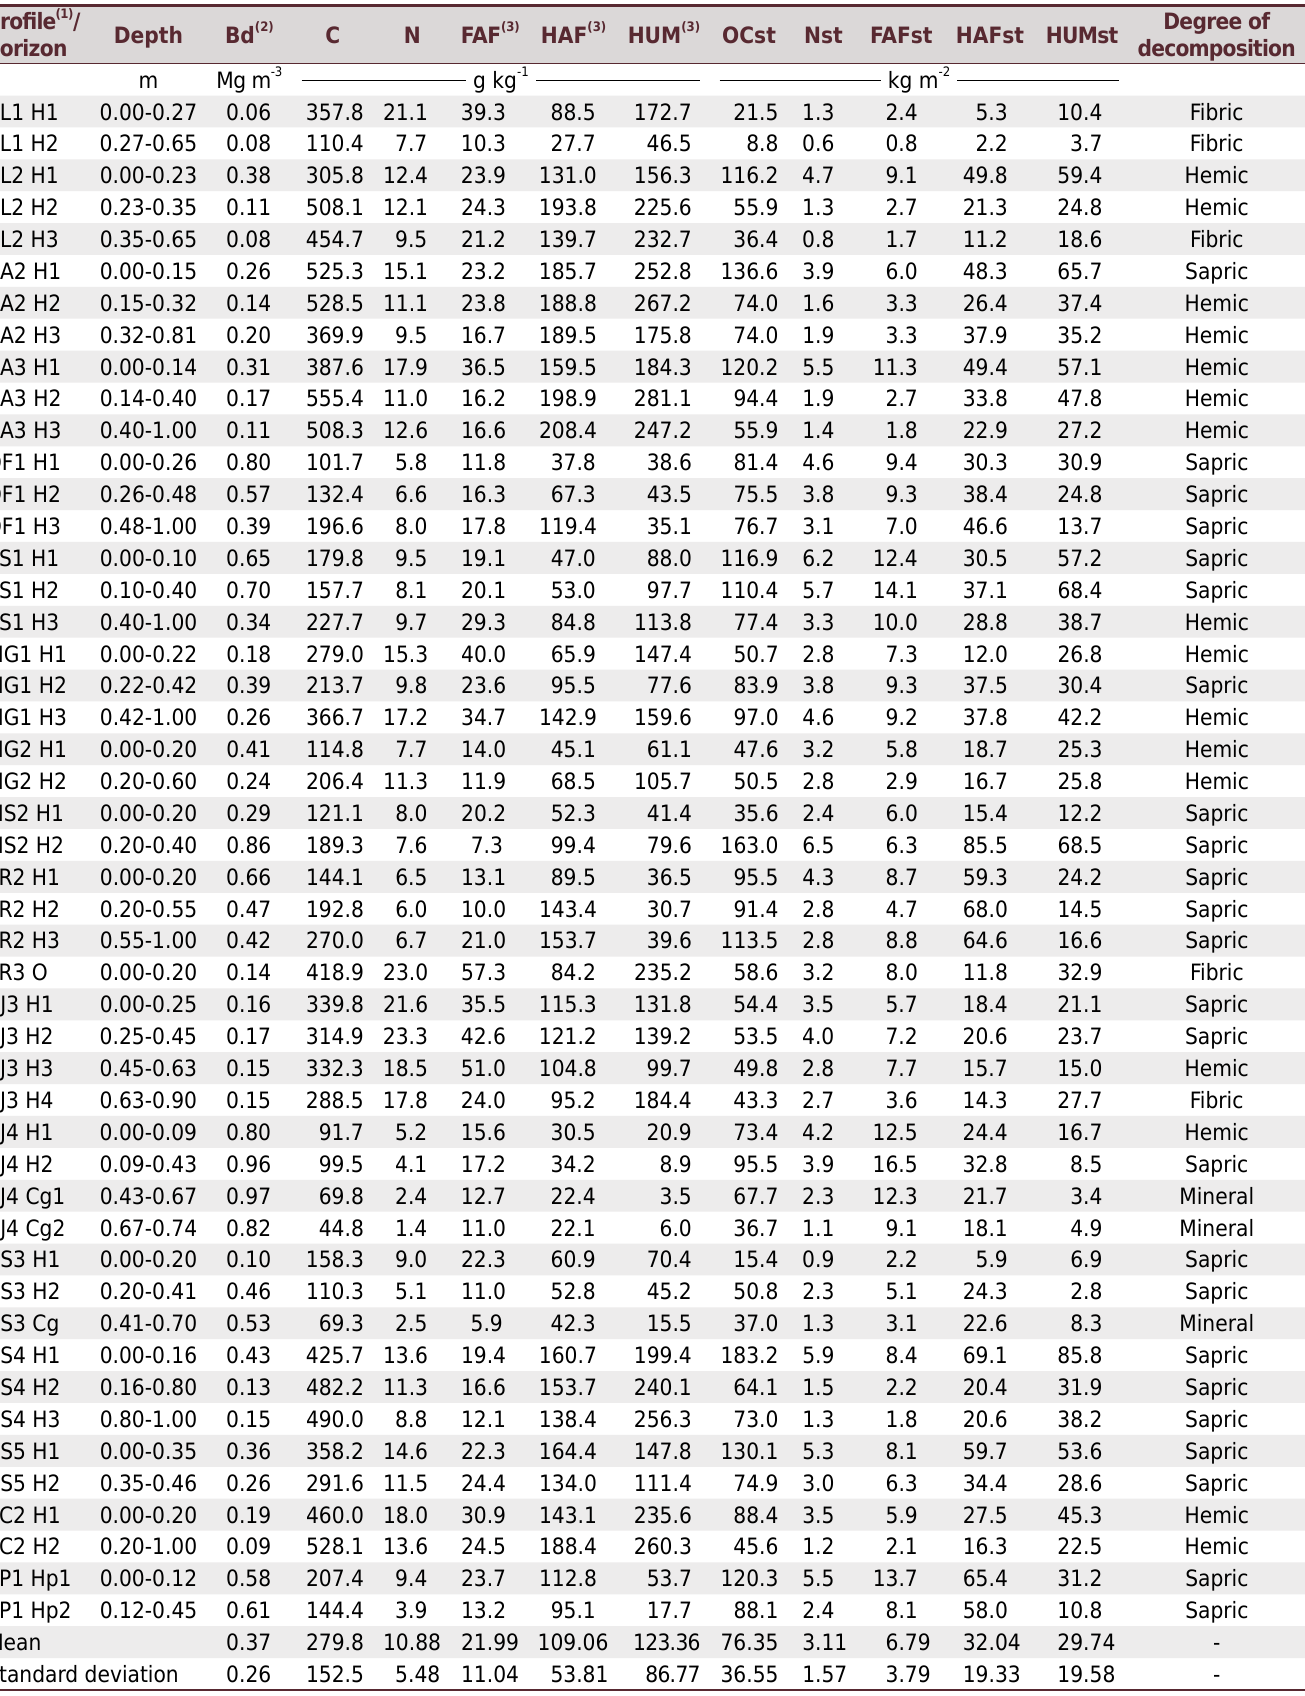
Table 4. Soil bulk density (Bd), carbon and nitrogen contents (C, N) and stocks (OCst, Nst) in the humic fractions (fulvic acid, FAF; humic acid, HAF; and humin, HUM), and degree of decomposition of organic matter in the Organosol profiles Profile (1) /